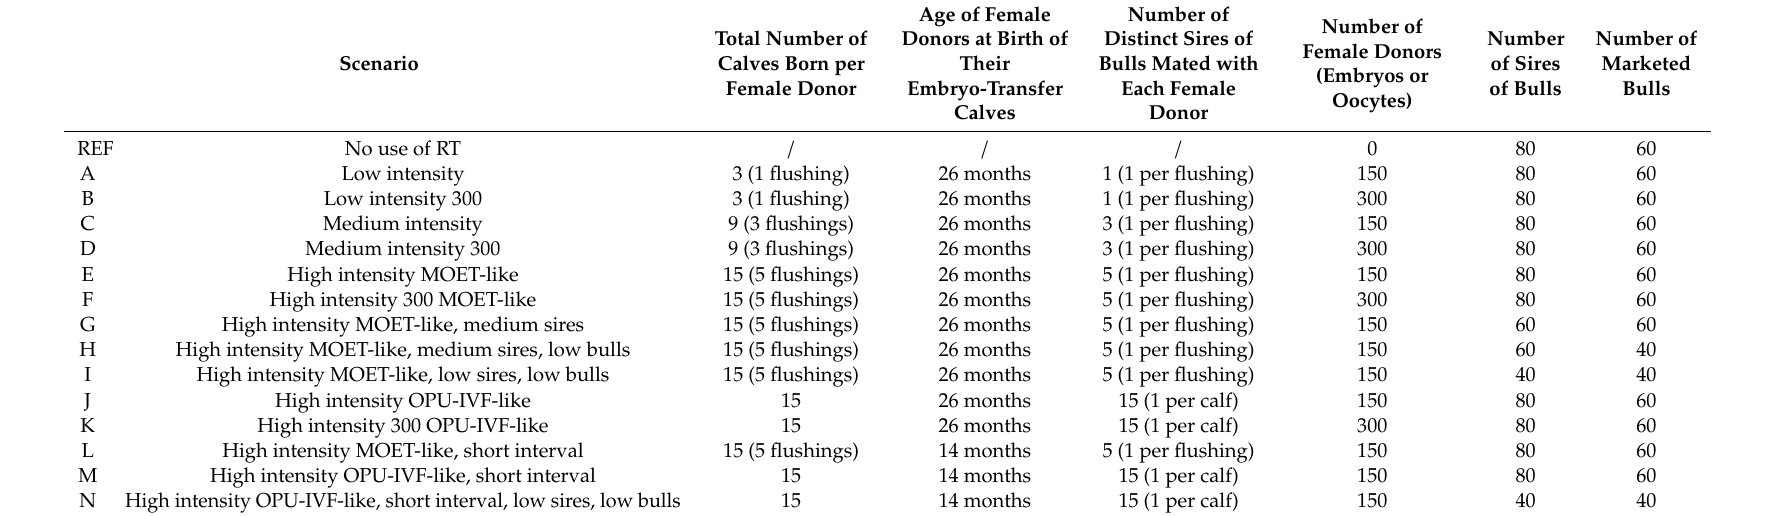
Table 1. Parameters used in di ff erent scenarios of the simulated dairy cattle breeding program based on the use of embryo transfer. Scenario